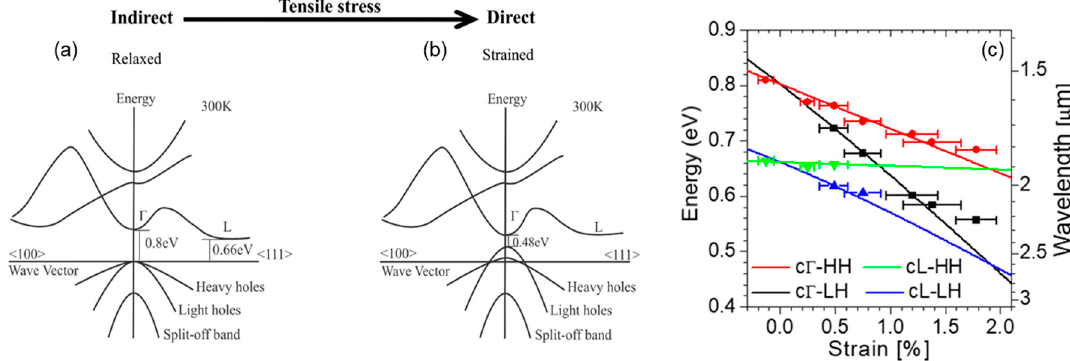
Figure 1. Strain-induced modifications of the Ge band structure. ( a ) Schematic band structure of unstrained Ge; ( b ) Schematic band structure of Ge under 1.9% biaxial tensile strain Reproduced with permission from [23]. American Chemical Society, 2014; ( c ) Solid lines: calculated bandgap energies between the Γ or L conduction-band minima and the HH or LH valence-band maxima of Ge as a function of biaxial strain. Symbols: peak emission energies extrapolated from the strain-resolved luminescence spectra shown in Figure 4a below. Reproduced with permission from [17]. National Academy of Sciences, 2011.